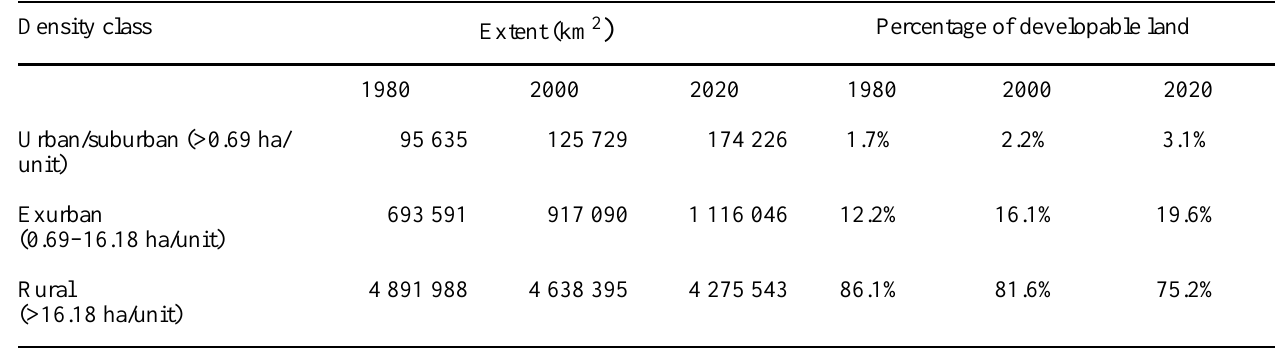
Table 1. The extent of development for the coterminous U.S., grouped by housing density class. “Developable” land includes private lands that do not have some protected designation. “Undevelopable” includes public (e.g., Forest Service, parks, etc.) and other protected lands (derived from DellaSala et al. 2001).